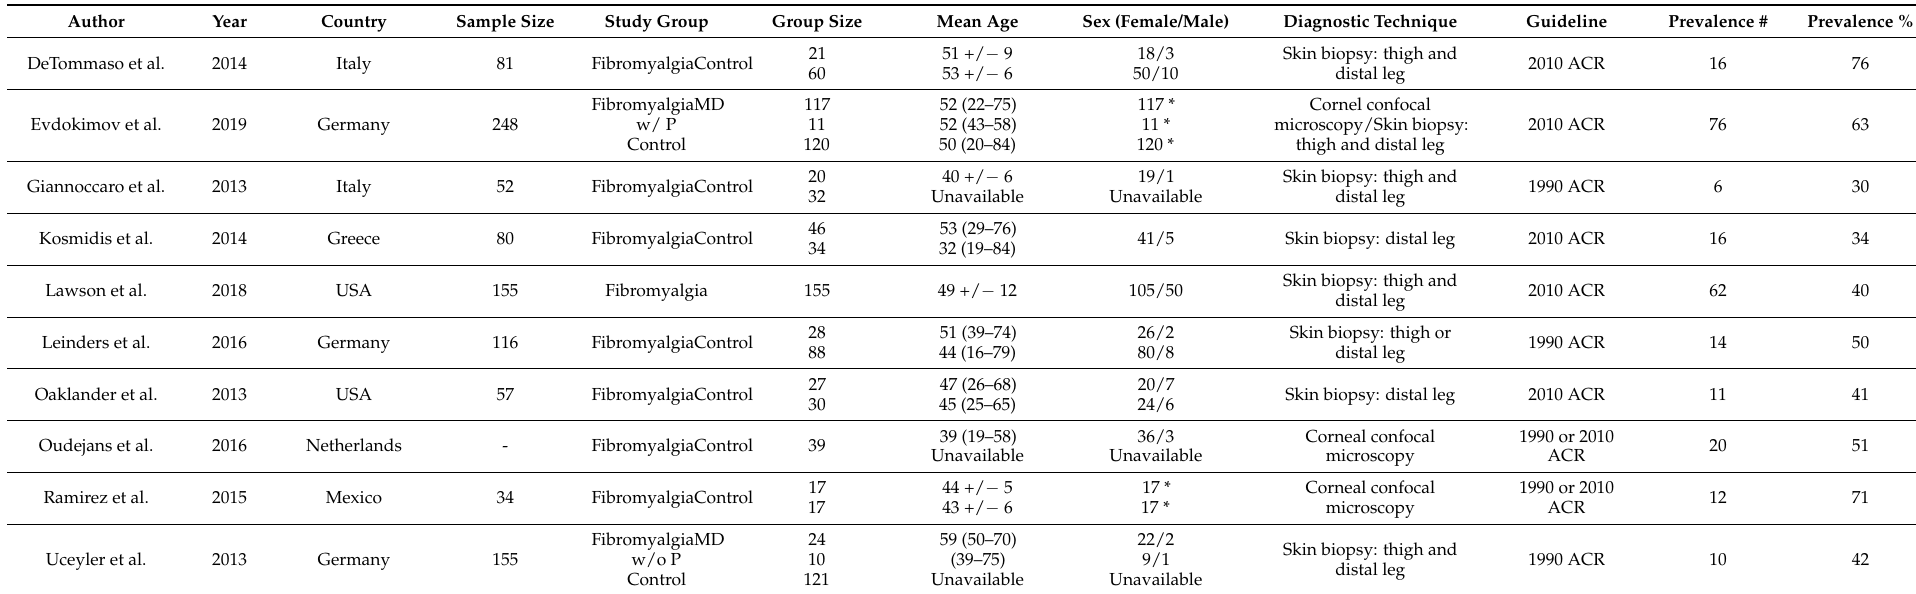
Table 6. Summary of studies that have demonstrated the presence of SFN in patients diagnosed with FM